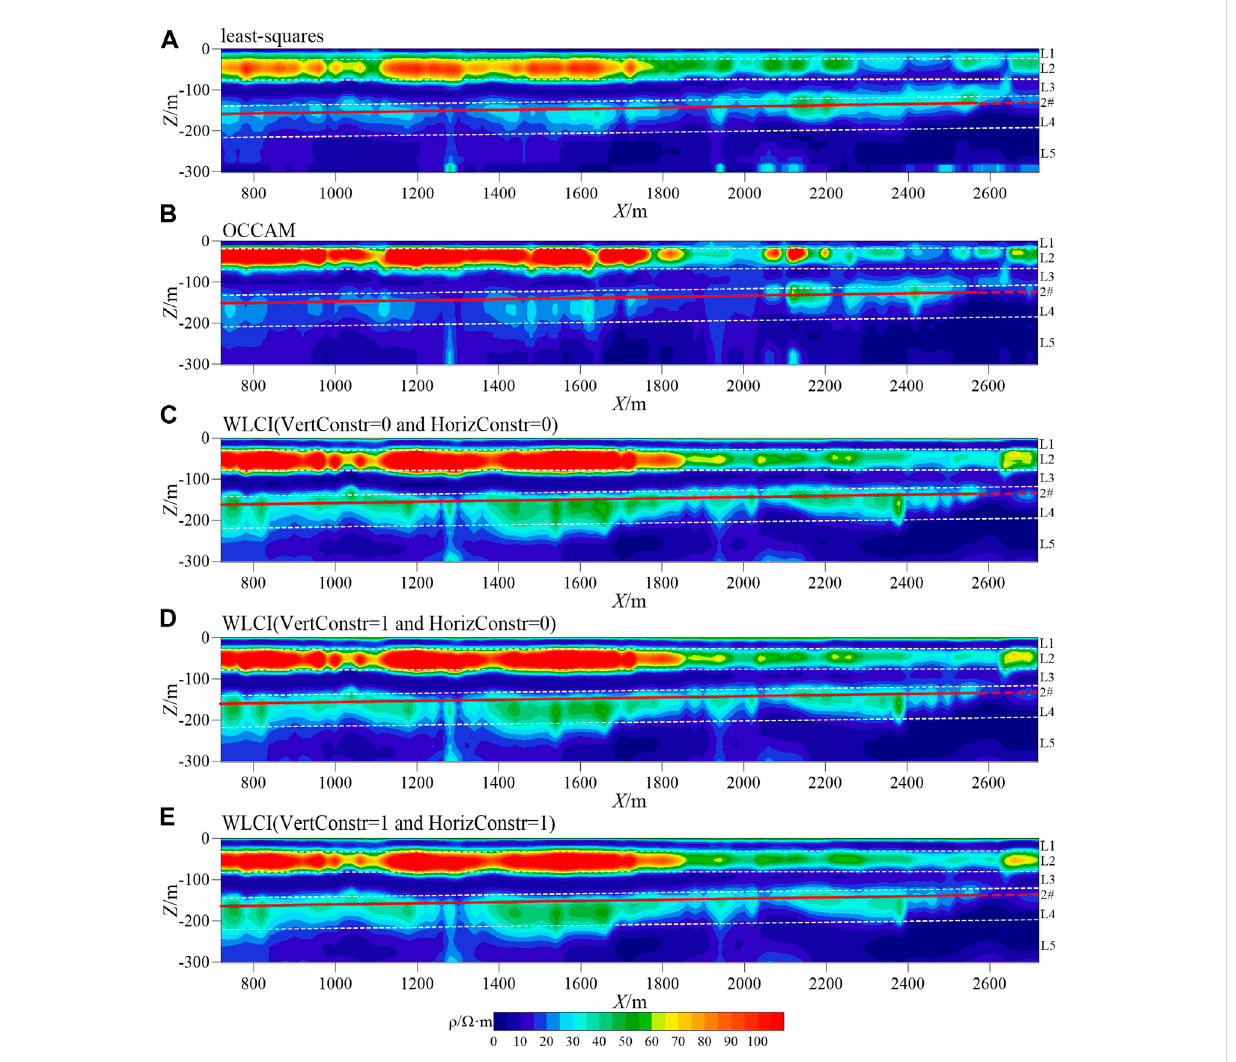
FIGURE 10 Fielddatainversionresults. (A) :least-squaresinversionresult. (B) :Occaminversionresult. (C) :WLCIinversionresultwhileverticalconstrained factor is 0 and horizontal constrained factor is 0. (D) : WLCI inversion result while vertical constrained factor is 1 and horizontal constrained factor is 0. (E) : WLCI inversion result while vertical constrained factor is 1 and horizontal constrained factor is